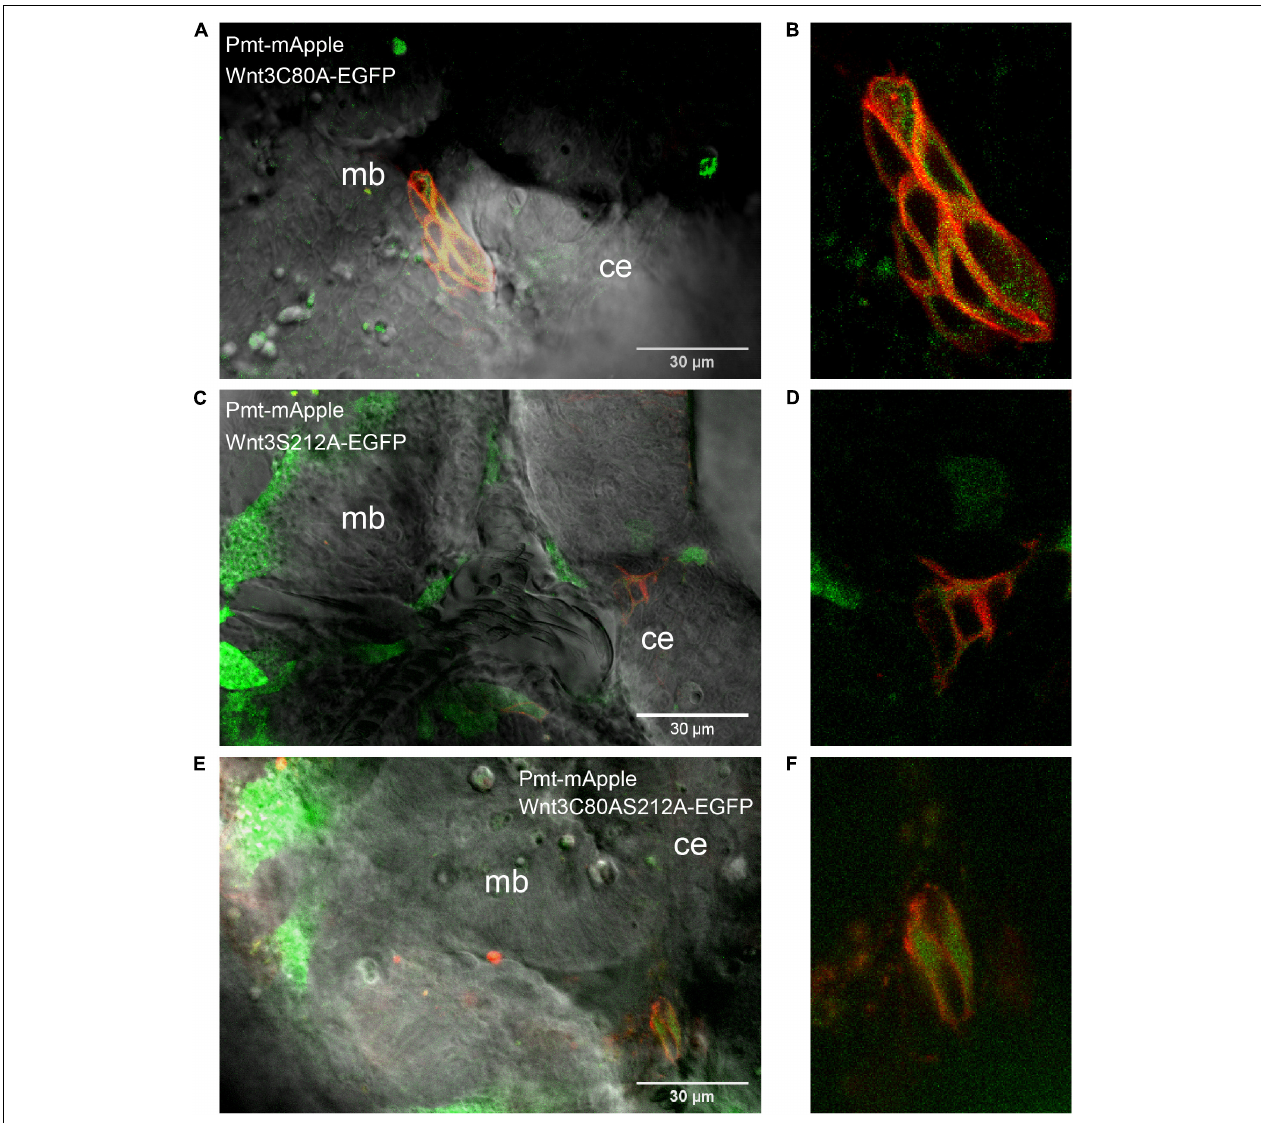
FIGURE 5 | Expression profile of the mutants co expressed with PMT-mApple. Co-expression of mutants (Wnt3C80A-EGFP, Wnt3S212A-EGFP, and Wnt3S212AC80A-EGFP) and PMT-mApple in the zebrafish brain at ∼ 48 hpf. PMT-mApple is a protein located on the inner leaflet of the cell membrane. It is expressed under a 4kb Wnt3 promoter and serves to mark the source cells of Wnt3 expression. (A) Expression profile of Wnt3C80A-EGFP co-expressed with PMT-mApple in zebrafish brain. (B) Expression of Wnt3C80A-EGFP co-expressed with PMT-mApple in the midbrain. (C) Expression profile of Wnt3S212A-EGFP co-expressed with PMT-mApple in zebrafish brain. (D) Expression of Wnt3S212A-EGFP co-expressed with PMT-mApple in the midbrain. (E) Expression profile of Wnt3C80AS212A-EGFP co-expressed with PMT-mApple in zebrafish brain. (F) Expression of Wnt3C80AS212A-EGFP co-expressed with PMT-mApple in the